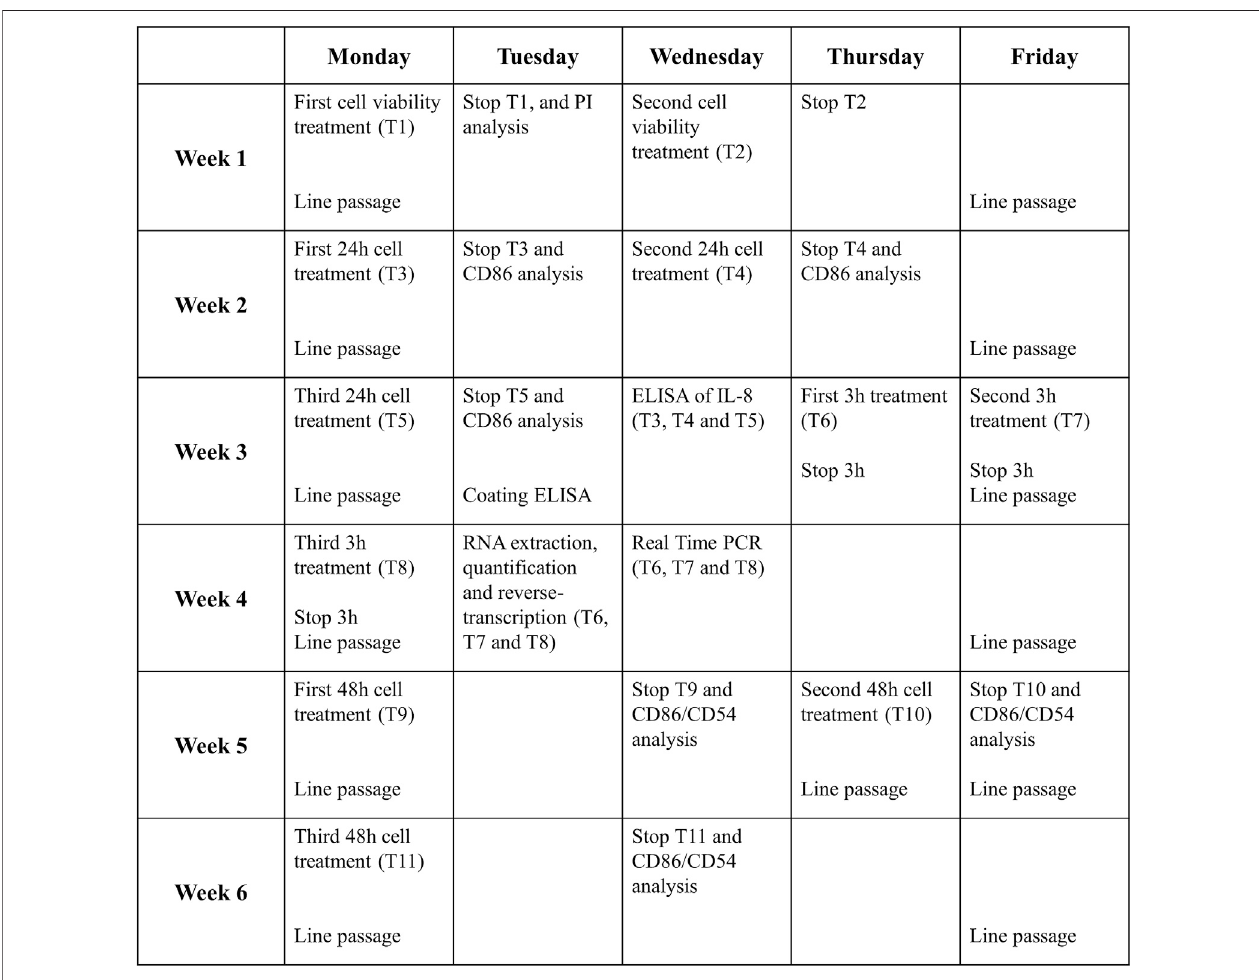
FIGURE 4 | Timeline of one complete drug analysis. The schedule represents the time required for the analysis of a drug which resulted to be non-sensitizer, for which all the steps of the protocol are required. The times can be reduced if the drug proves the sensitizing potential already at earlier stages of the protocol.